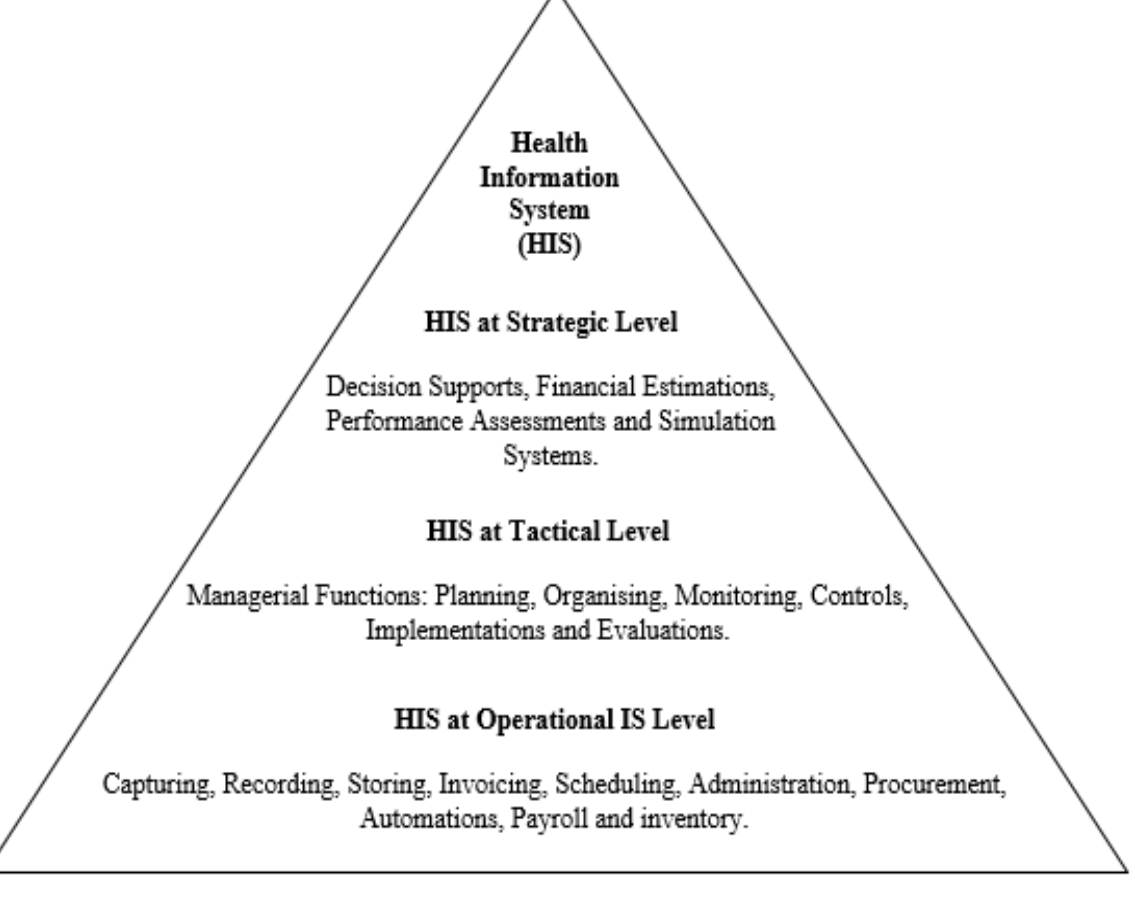
Figure 3. Levels of HIS deployment: source authors.